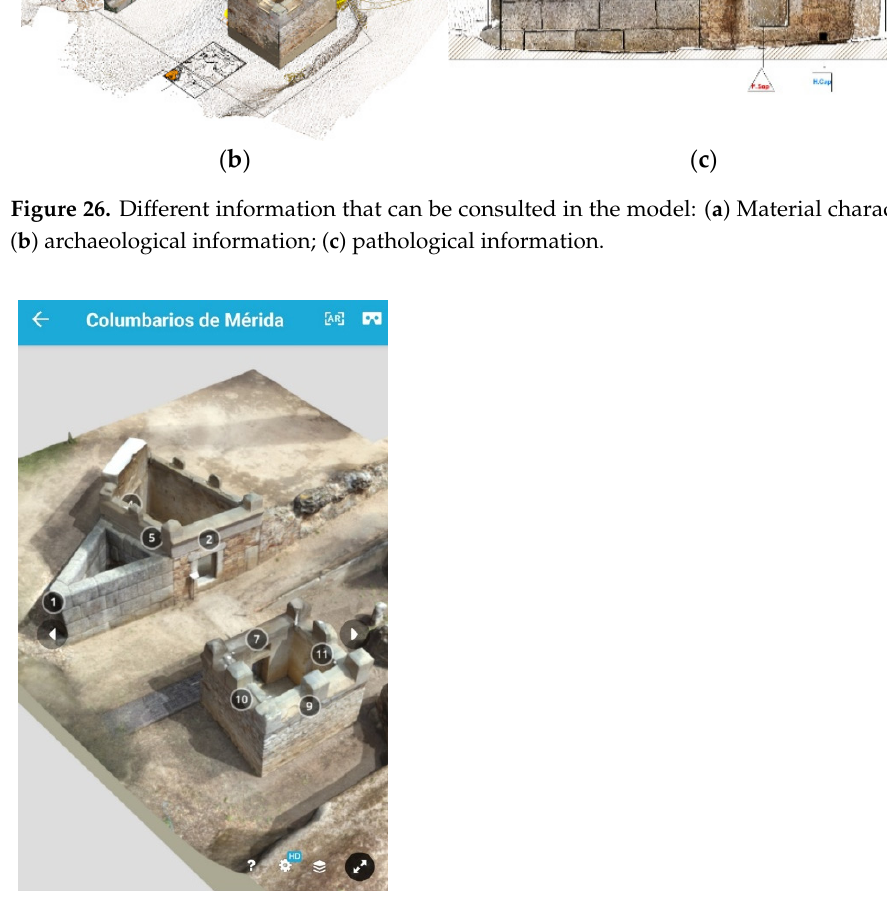
Figure 27. Screenshot of the mobile displaying the 3D model of the Columbarios .